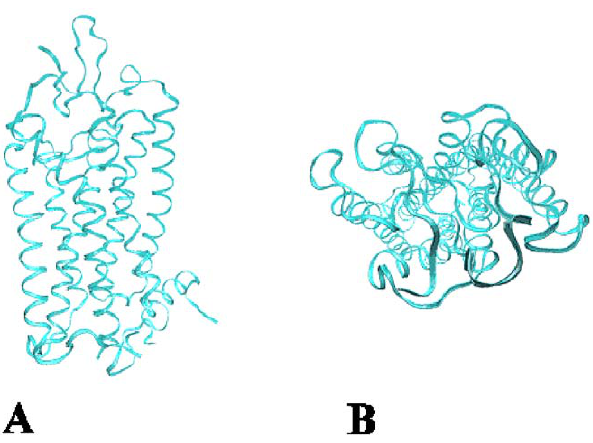
Figure 3. The crystal structure of bovine rhodopsin.